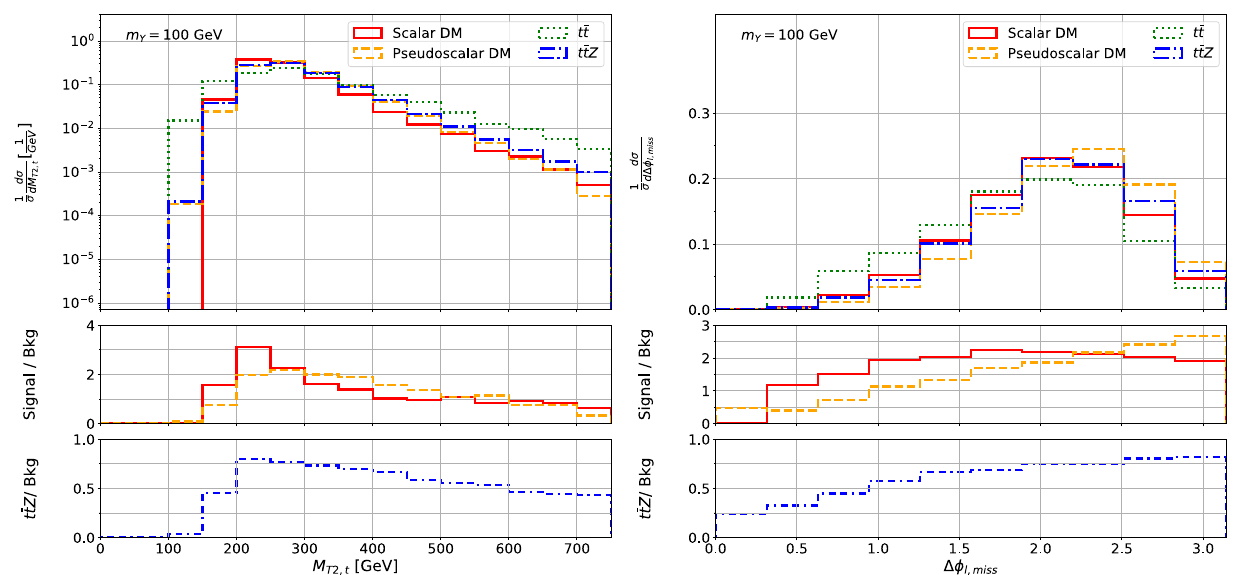
√ s = 13 TeV. In the respective central panels we show the signal-to- background ratio including the respective lepton flavour factors. The lower panels depict the fraction of the t ¯ tZ contribution to the